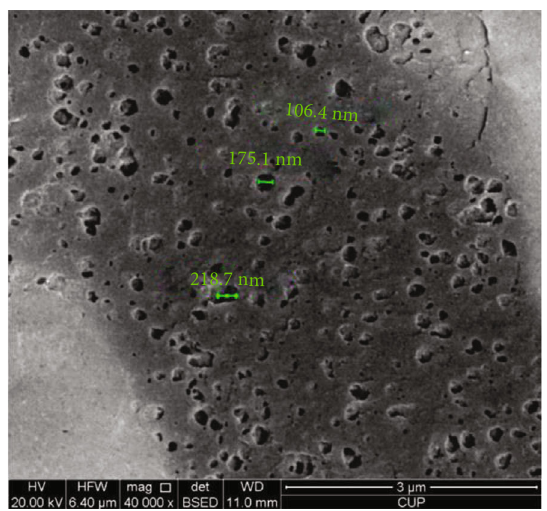
Figure 1: SEM images of shale organic pores